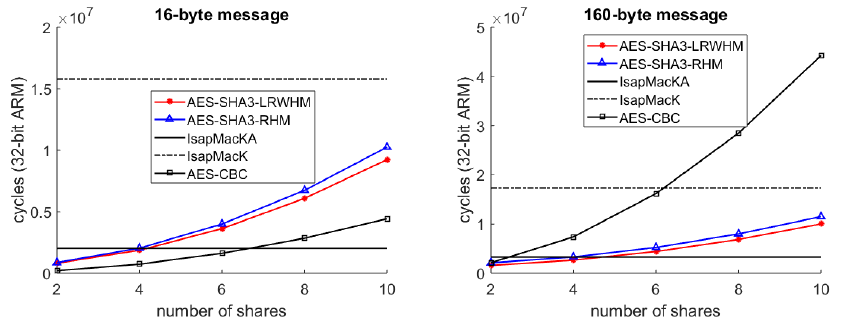
Figure 7: Performance (II): the clock cycles of AES-SHA3- LRWHM , AES-SHA3- RHM , IsapMac s and AES-CBC with varying the number of shares (lower is